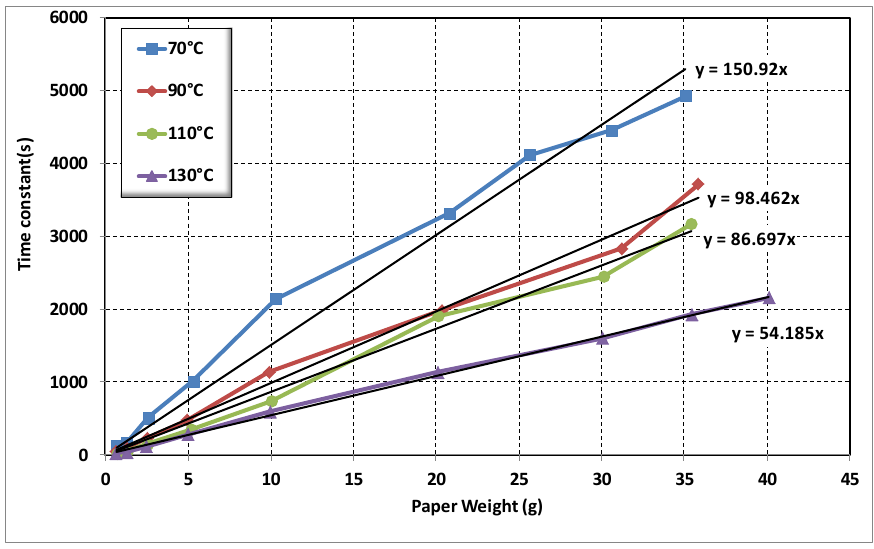
Figure 5. The time constant evolution, depending on the paper weight and drying temperature.